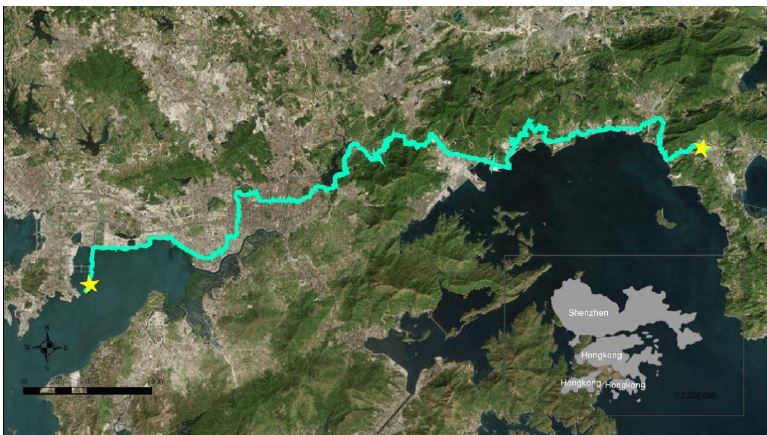
Figure 1. The walking trajectory of the 2016 “Shenzhen 100 km Walking” event.